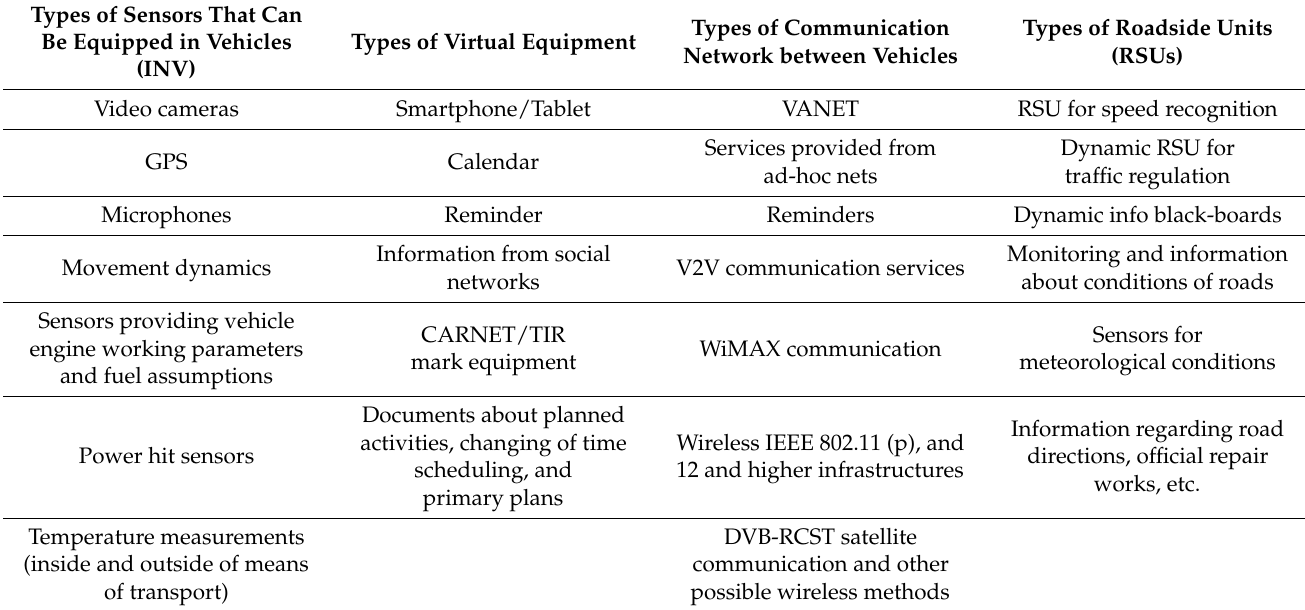
Table 3. Types of sensors that can be equipped in means of transport and RSUs for contextual data assessment. Types of Sensors That